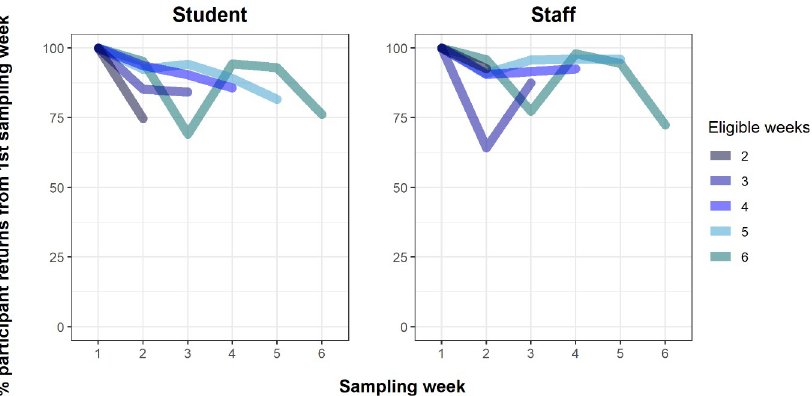
Fig 1. Participant return rates of students and staff per eligible sampling